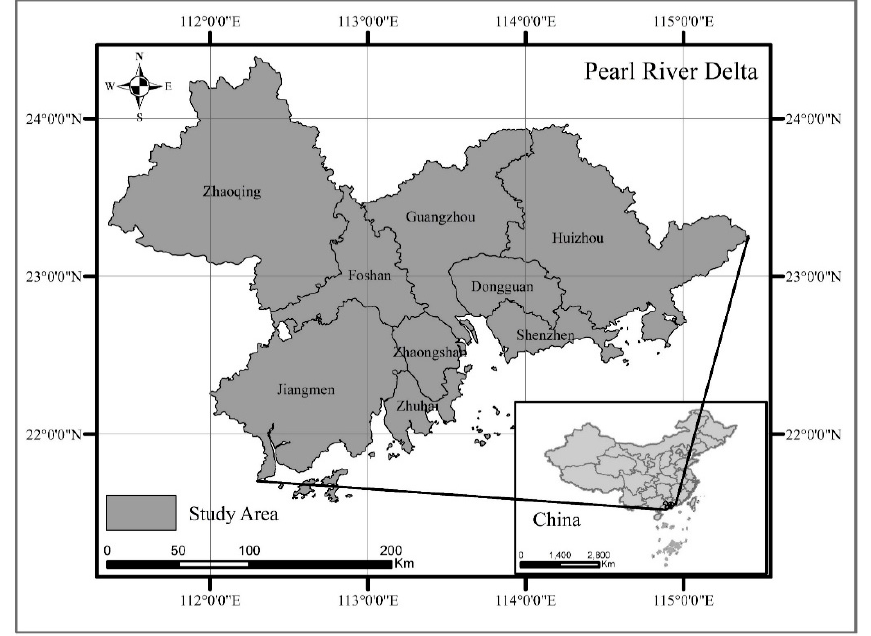
Figure 1. PRD urban agglomeration.